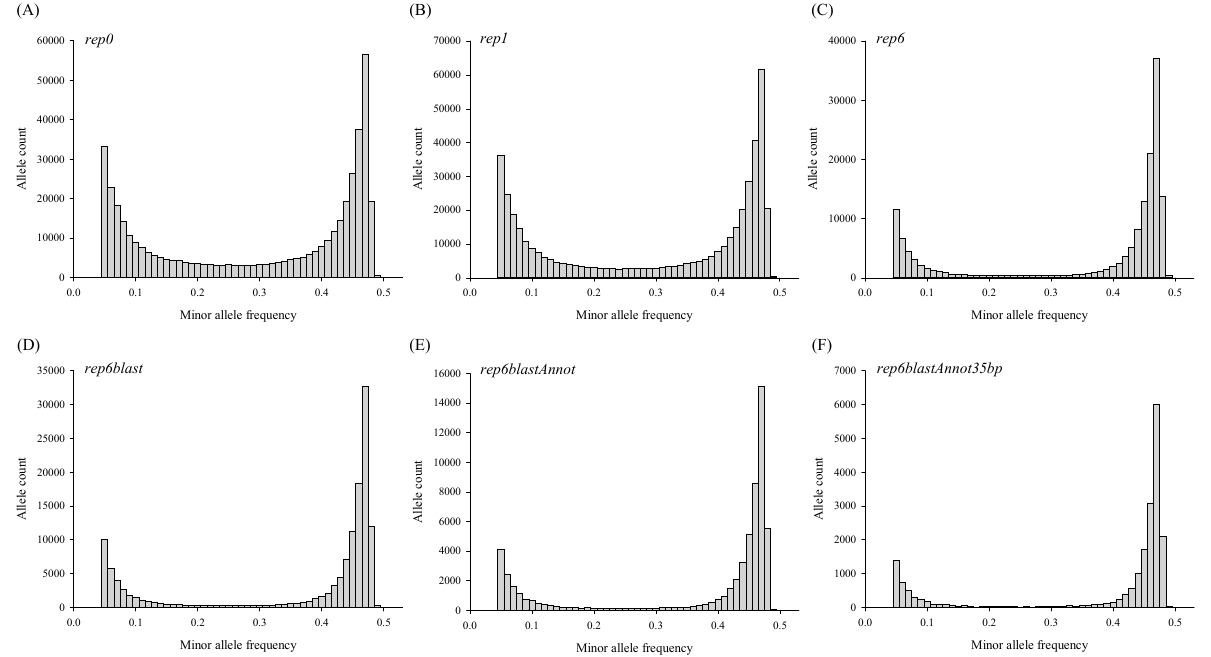
Figure 1. The minor allele frequency distribution in different SNP datasets of rep0 ( A ) , rep1 ( B ), rep6 ( C ), rep6blast ( D ) , rep6blastAnnot ( E ), and rep6blastAnnot50bp ( F ) with the missing <= 5% and minimum minor genotype count ≥ 4 in 299 Masson pine samples.